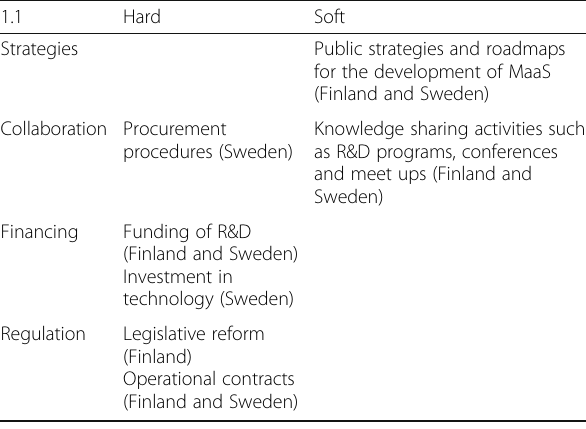
Table 3 Policy instruments utilized by public actors in the development of MaaS in Finland and